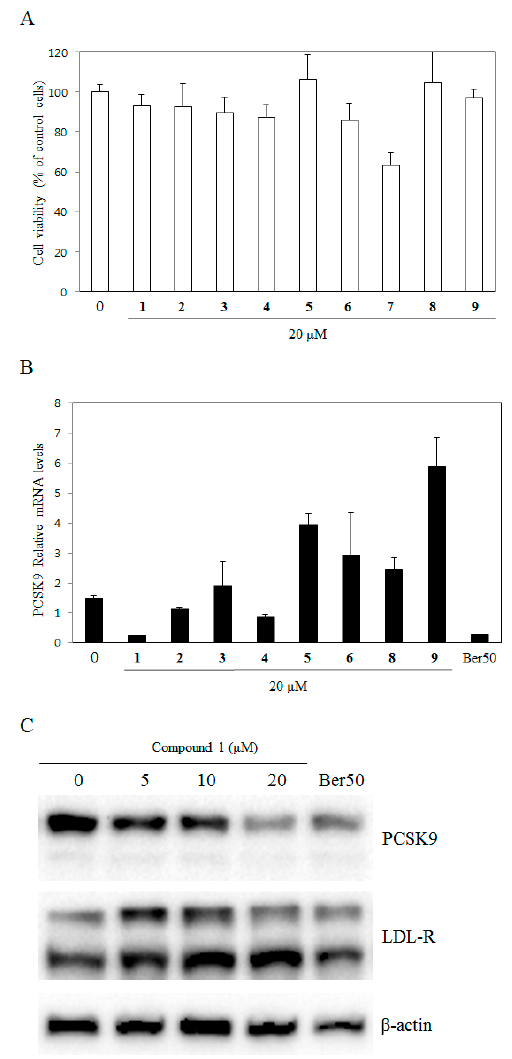
Figure 3. Effects of compounds from S. baicalensis on Cell viability, PCSK9 and LDL-R expression in HepG2 cells by MTT, qRT-PCR and western blot analysis. ( A ) Cells grown were treated with 20 µM of compounds for 24 h, and cell viability was assessed by the MTT assay; ( B ) Expression of PCSK9 was assayed by qRT-PCR in cells treated with compounds 1 – 9 except for 7 , and berberine (50 μ M) for 24 h; ( C ) Expression of PCSK9 and LDL-R were assayed by western blots in cells treated with ( 1 ) and atorvastatin for 24 h. (Ber50, berberine 50 μ M).